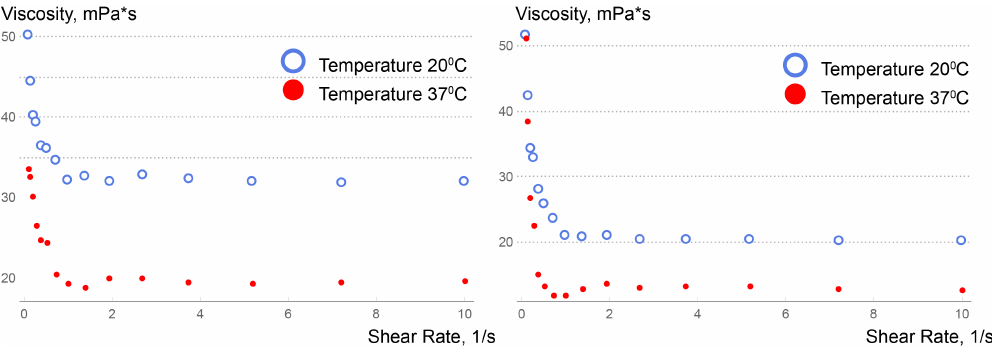
Figure 15. Comparison of experimental data on viscosity versus shear rate for Onyx-18 (cid:114) ( left ) and (cid:114) Squid-12 ( right ) embolic polymers.